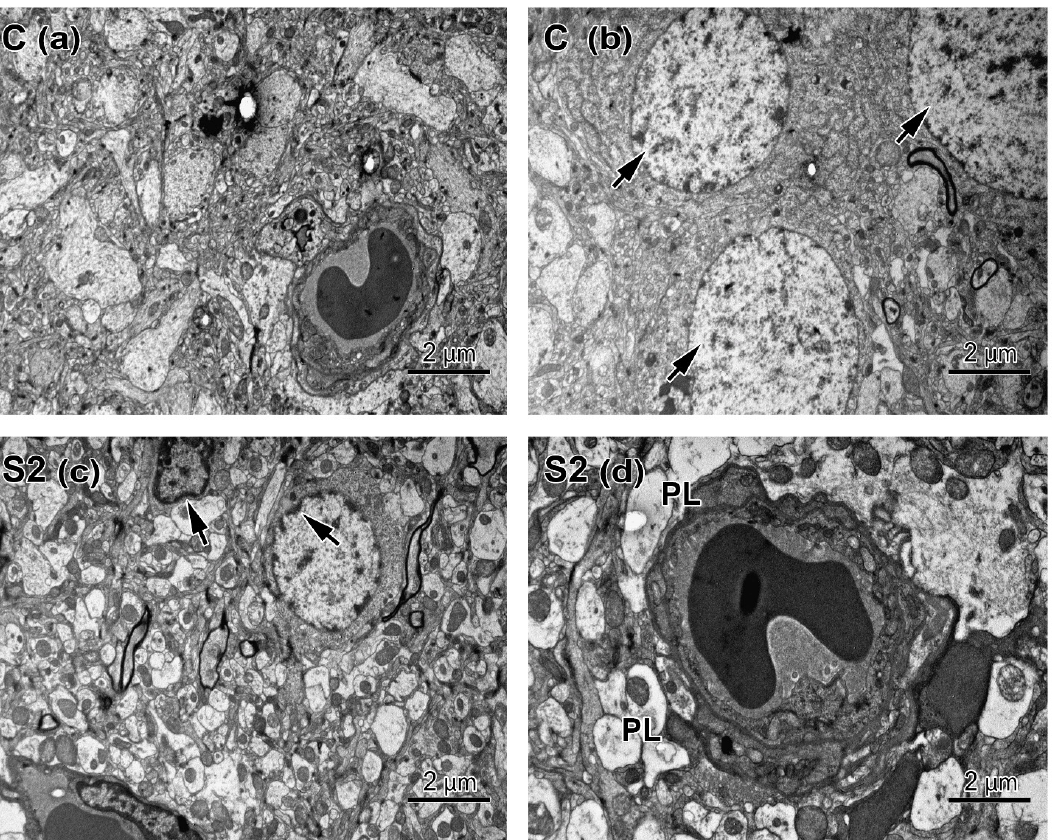
Figure 7. Electron micrographs showing neurons, glial cells, and capillaries. ( a ) The compact aspect of the neuropil in the CA3 area in Control; ( b ) The neuronal somas (black arrows) triad with regular nuclear shapes in the CA3 area of Control; ( c ) Oligodendrocyte and microglia without considerable changes in nuclear contours (black arrows) after 2 days of repeated restraint stress; ( d ) Perivascular lysis (PL) in CA3 hippocampal area after 2 days of repetitive exposure to restraint stress. Original magnification ×6000.